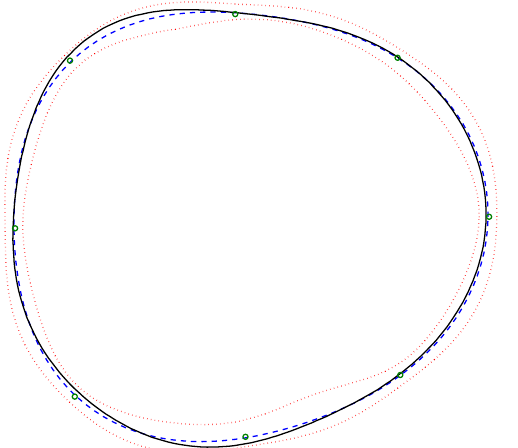
Fig. 4. Representation of the form of a circular artefact (solid curve), measured coordinates (circles), the best estimate of the form (dashes), reconstructed on the basis of the measured data and the spatial correlation, the uncertainty band representing plus and minus two standard deviations for the form (dots).